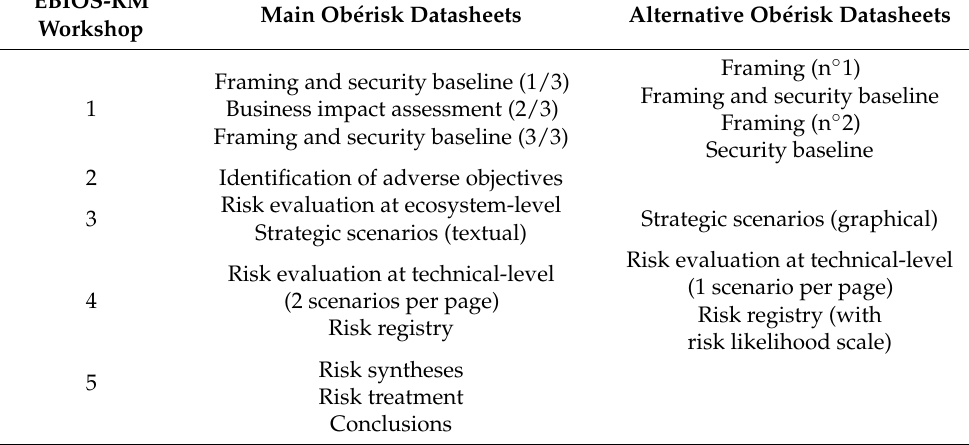
Table A1. Ob é risk framework.